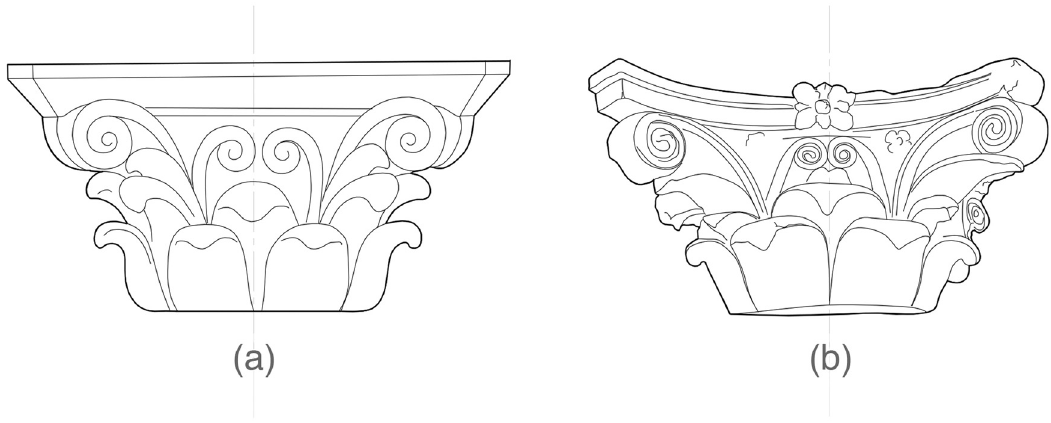
Figure 12: Corinthian capitals distinctive to Egypt in Roman period – McKenzie type 3: ( a ) Mons Claudianus and ( b ) Luxor “ Imperial Cult Chamber ” ( drawing: S. Pop ł awski, based on McKenzie, 2007, pp. 223 – 224 ) .